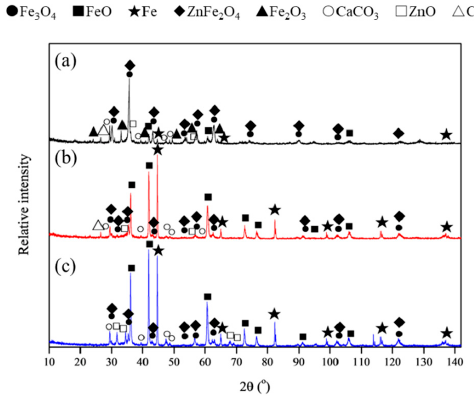
Figure 1. XRD patterns of the three BOS filter cakes: ( a ) BOS-1; ( b ) BOS-2; ( c ) BOS-3.